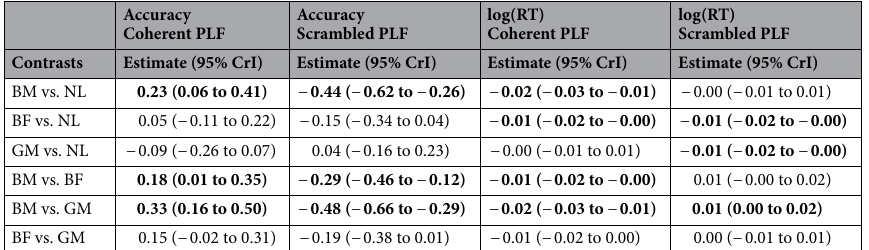
Table 1. Accuracy and RT results for Experiment 1. Cue names are as follows: BM biological motion, BF biological form, GM general motion, NL no language. Bolded are estimates and credible intervals that did not cross